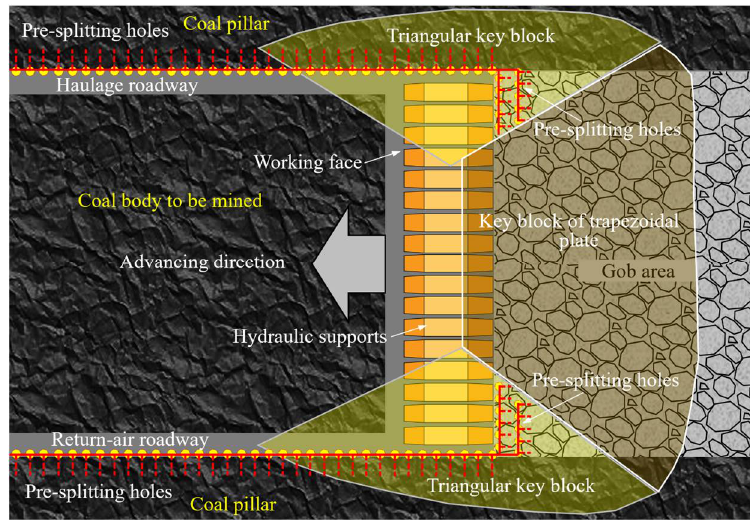
Figure 15. Fracturing operation of a hard roof at the end of the working face.